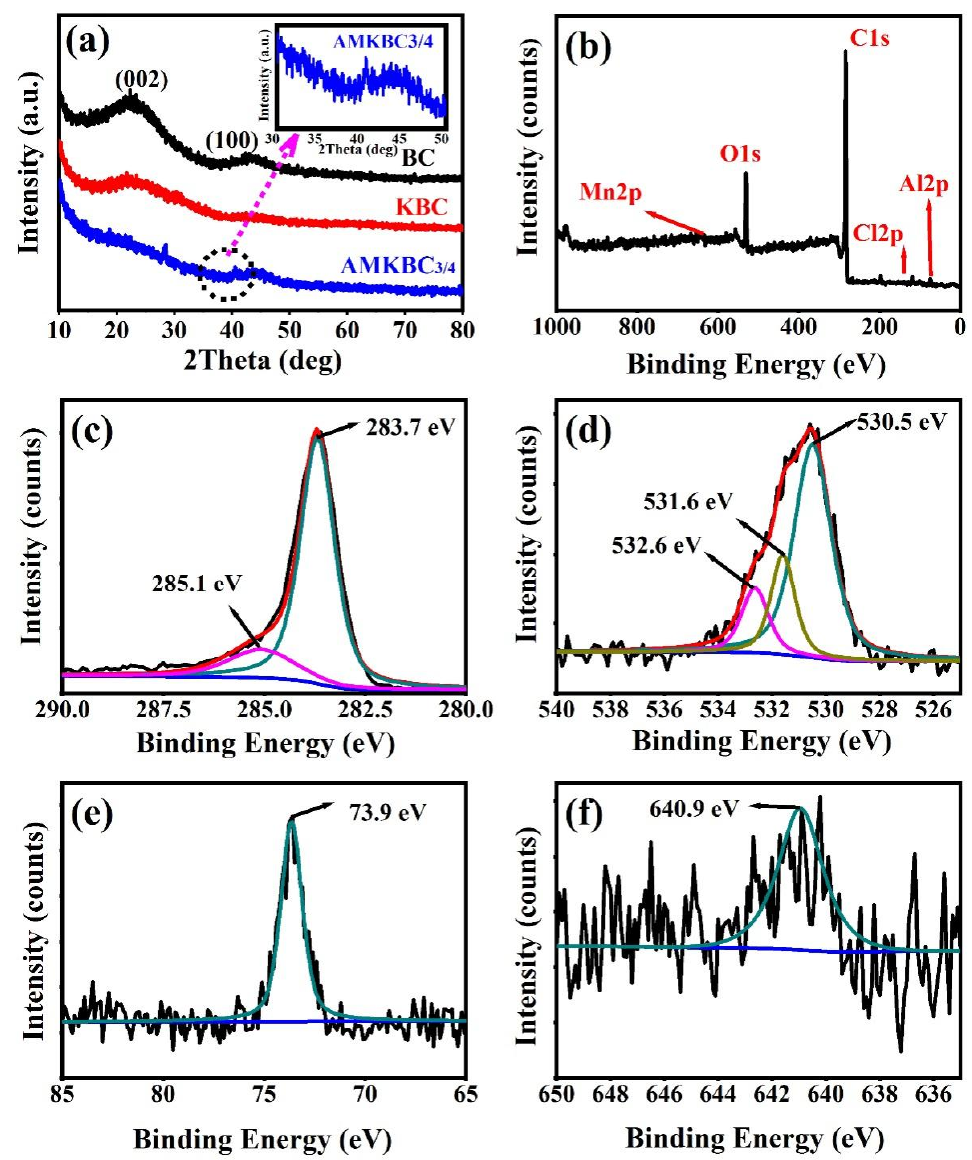
Figure 3. X-ray diffraction analysis of BC, KBC, and AMKBC 3/4 ( a ). For AMKBC 3/4 : XPS spectra ( b ); high resolution XPS spectra of C1s ( c ); O1s ( d ); Al2p ( e ); Mn2p3/2 ( f ). The visible peaks of C1s, O1s, Al2p, and Mn2p for AMKBC 3/4 (Figure 3b–f) confirmed the loading effect of Al/Mn oxides, which was consistent with the EDS analysis. The peaks located at 283.7 eV and 285.1 eV represented the functional groups of C–N and C=C of the AMKBC 3/4 in the high-resolution XPS spectrum (Figure 3c) [27]. The O1s spectrum had three peaks (Figure 3d): the peak of 531.6 eV can be ascribed to the lattice oxygen (CO, C=O) [28]; the peaks of 532.6 eV and 530.5 eV are attributed to the oxygen from organic